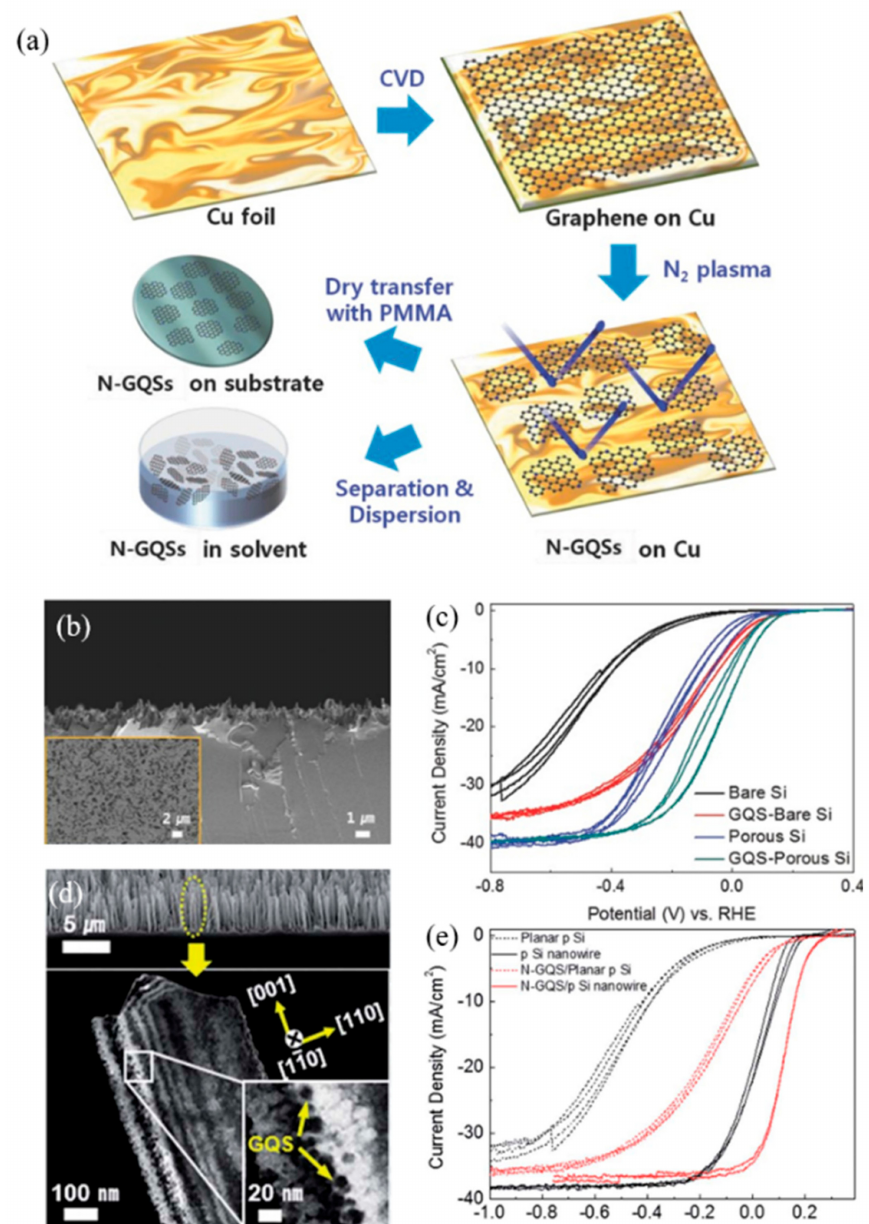
Figure 7. Graphene quantum sheets (GQSs) applied in photoelectrochemical cells for water splitting reactions. ( a ) Schematic illustration of N-doped graphene quantum sheets (N-GQSs) fabrication processes. ( b ) Cross-section SEM image of porous Si, inset shows top-view SEM image of porous Si. ( c ) Cyclic Voltammetry (CV) of N-GQSs on bare Si and porous Si [27]. ( d ) Cross-section SEM image and dark-field TEM images of N-GQSs on p-type silicon nanowires (p-SiNWs). ( e ) Photocurrent density—potential (J–E) curves for lightly boron-doped planar p-Si electrode and silicon nanowire electrode deposited with N-GQSs